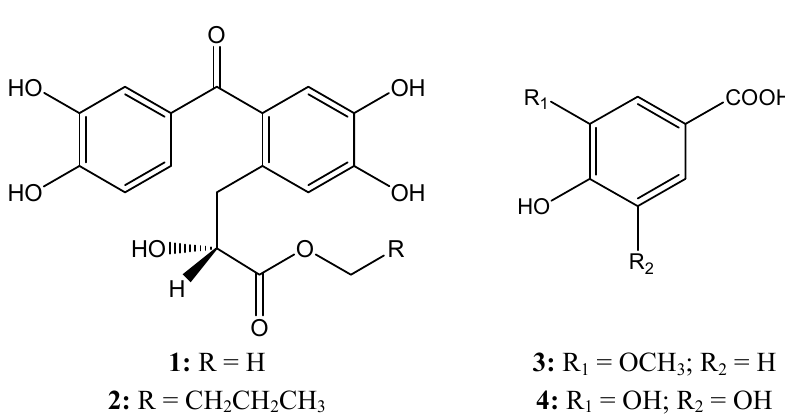
Figure 1. The structures of compounds 1 – 4